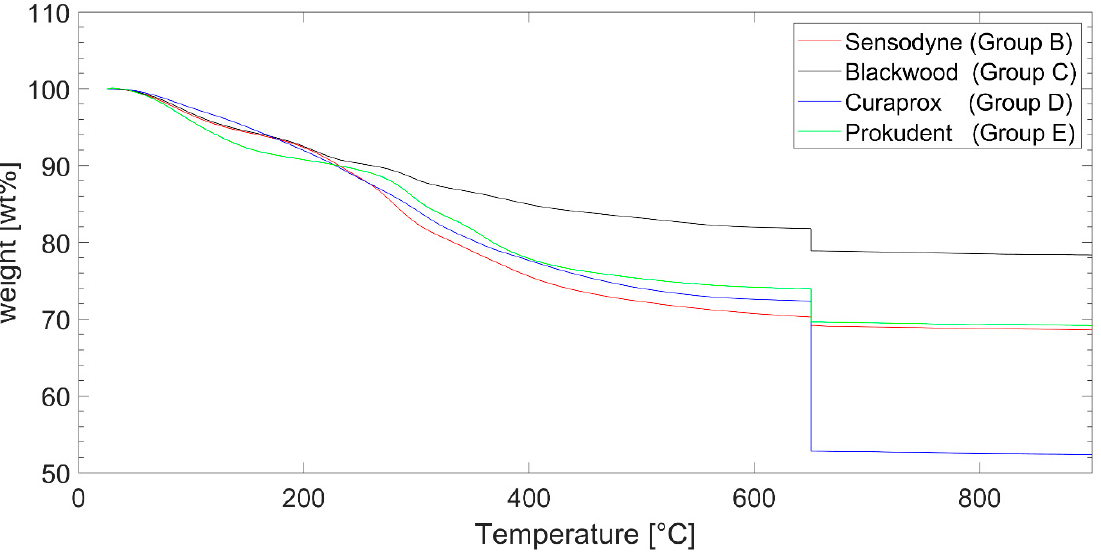
Figure 2. Weight loss during thermogravimetric analysis (TGA) of the groups. Nitrogen atmosphere was used from 25 °C to 650 °C. Above 650 °C, the chamber was flooded with oxygen. Table 3. Calculations of the activated charcoal and inorganic content according to the TGA measurements. The ‘total solids content’ refers to the solid content after centrifugation and drying divided by the weight of the used toothpaste. ‘Weight loss above 650 °C’ and ‘Inorganic residue after TGA’ refer to the ‘total solids content’. The last two columns are given relative to the toothpaste weight.